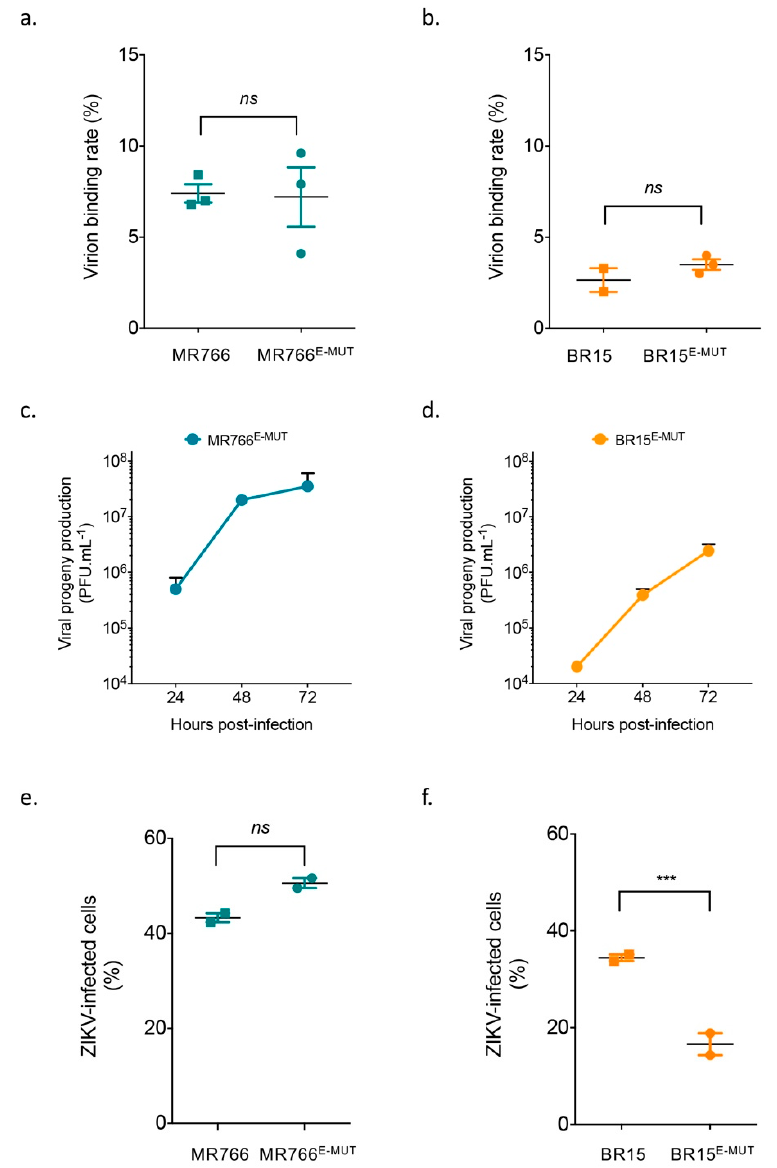
Figure 2. Analysis of virus binding and viral growth in A549-Dual ™ . In ( a ) and ( b ), for virus binding assays, cells were incubated with viral clones at the MOI of 1 for 1 h at 4 ◦ C. The number of virus particles bound to cell surface was measured by RT-qPCR. Values represent means and standard errors of three independent experiments. In ( c ) and ( d ), A549-Dual ™ were infected with BR15 E-MUT and MR766 E-MUT at MOI of 1. Infectious virus released into the supernatants of infected A549-Dual ™ cells were quantified at 24, 48 and 72 hpi. Error bars represent standard errors of at least two independent experiments. In ( e ) and ( f ), A549-Dual ™ were infected with BR15 E-MUT and MR766 E-MUT and parental clones at MOI of 1. Percentages of ZIKV-infected cells were determined at 48 h by flow cytometry using anti-E mAb 4G2 as primary antibody. Error bars represent standard errors of two independent experiments in duplicates. ns : not significant, ***: p value < 0.001